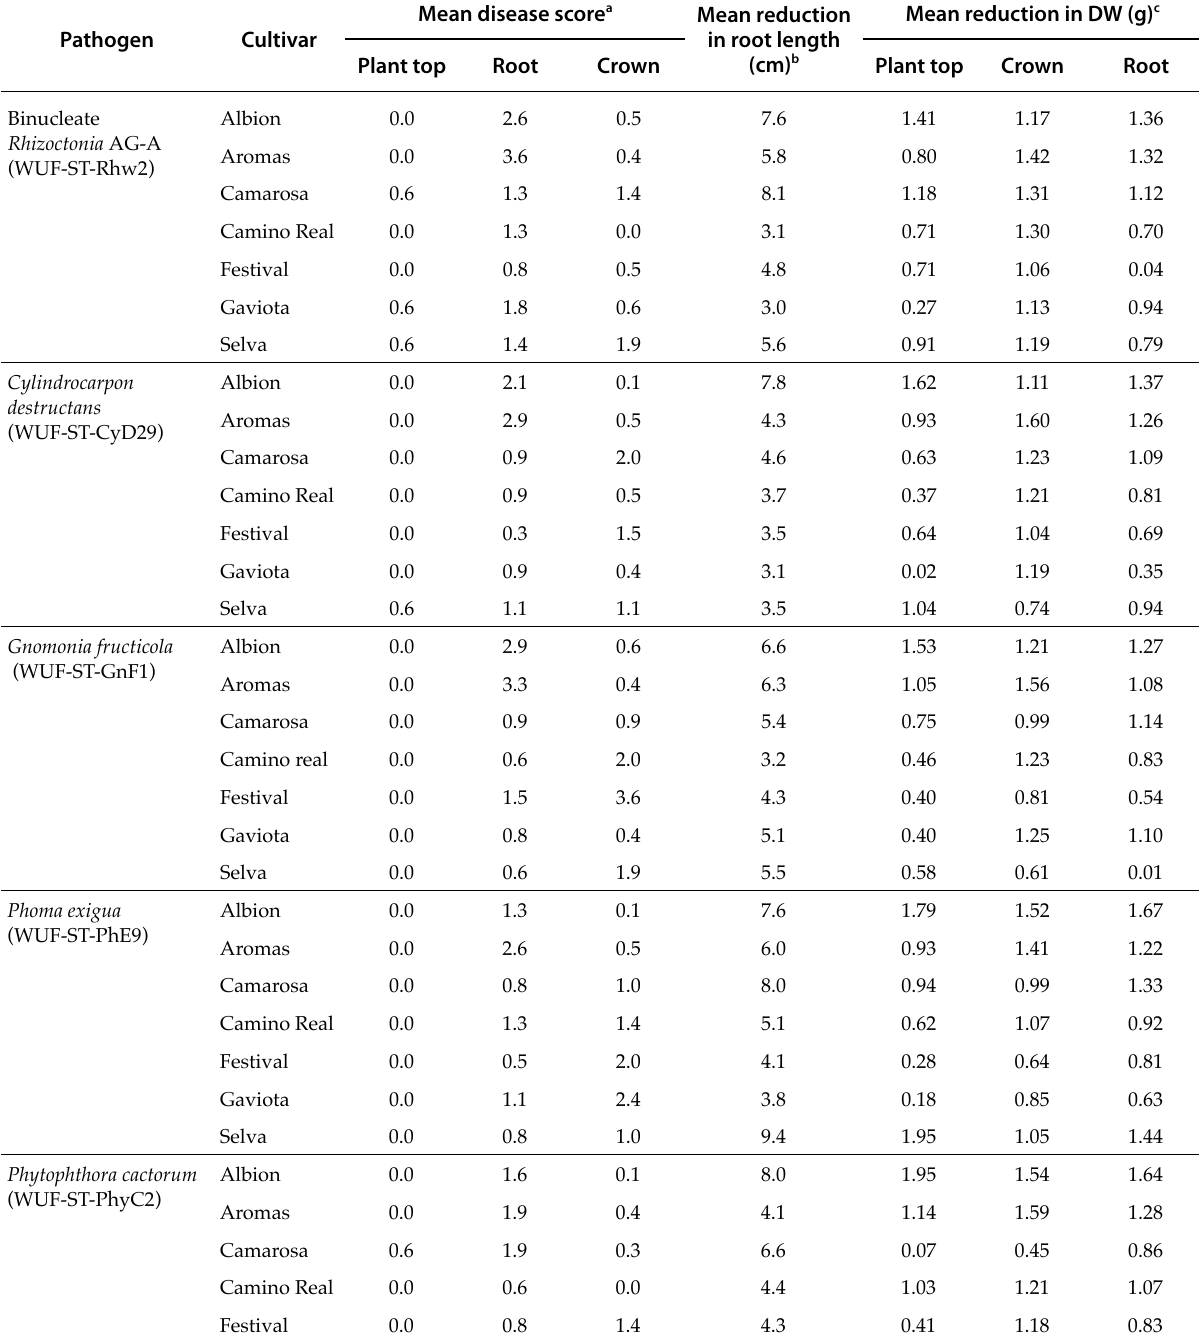
Table 5. Response of strawberry cultivars to different fungal and oomycete pathogens assessed as disease score (0‒5 scale) for plant top, root and crown, reduction in root length (cm), reduction in dry weight (DW) (g) of plant top, root and crown under controlled enrironment conditions, and analysis of variance for each parameter assessed in relation to pathogen and cultivar. Mean reduction in DW (g) c Mean disease score a Mean reduction in root length Pathogen Cultivar (cm) b Plant top Root Crown Plant top Crown